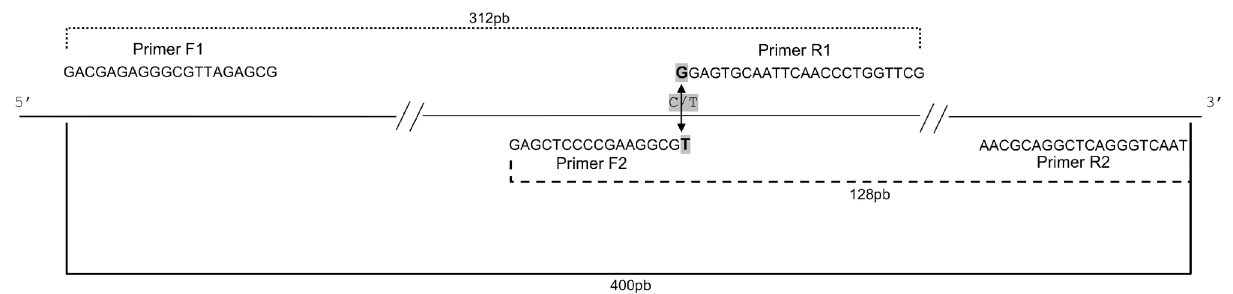
Figure 1. Design of the primers: 312 bp, ······, primer-amplified fragments corresponding to allele C. 128pb, ▬ ▬ , primer- amplified fragments corresponding to the allele T. In ▬ ▪ ▬ , fragment generated by primers F1 and R2 representing the positive